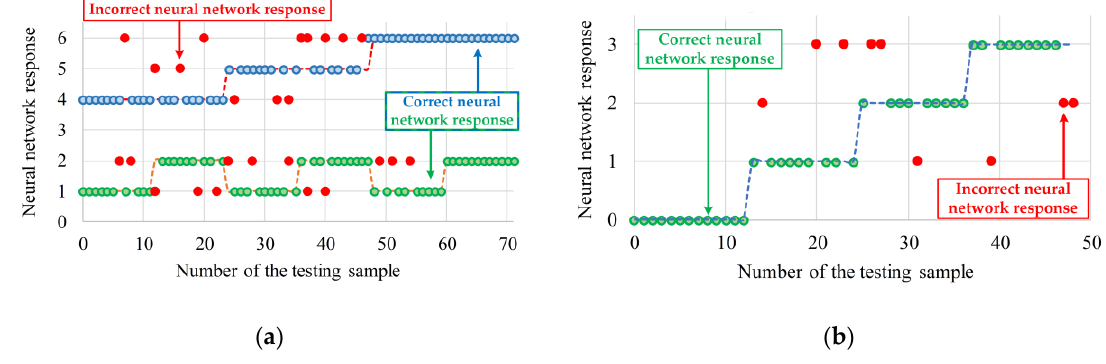
Figure 12. SOM–RHN network response: ( a ) mixed faults (blue dots—stator winding fault; green dots—rotor bar fault); ( b ) rotor broken bars, T L ≈ 0 ( s ≈ 0).